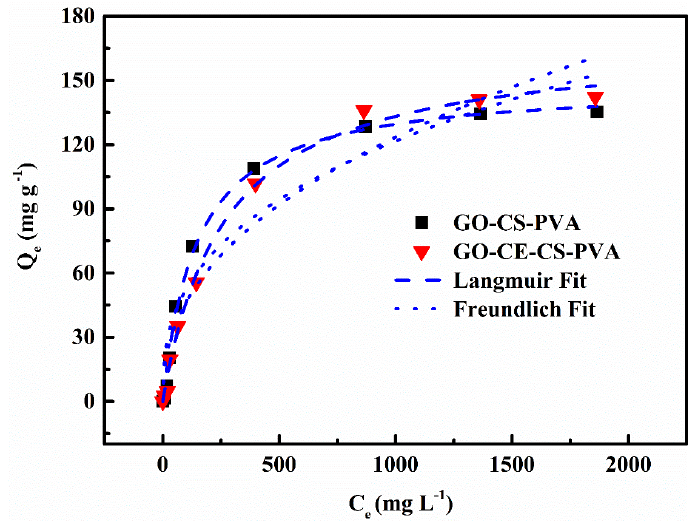
Figure 8. The adsorption isotherm data and model of GO–CE–CS–PVA and GO–CS–PVA for Li + . Table 2. Langmuir and Freundlich parameters of GO–CE–CS–PVA and GO–CS–PVA. Langmuir Isotherm Equation Adsorbents